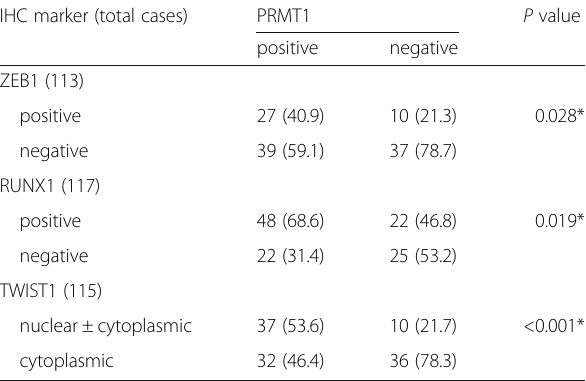
Abbreviations: PRMT1, protein arginine methyltransferase 1; ZEB1, Zinc Finger E-Box Binding Homeobox 1; RUNX1, Runt-related transcription factor 1;